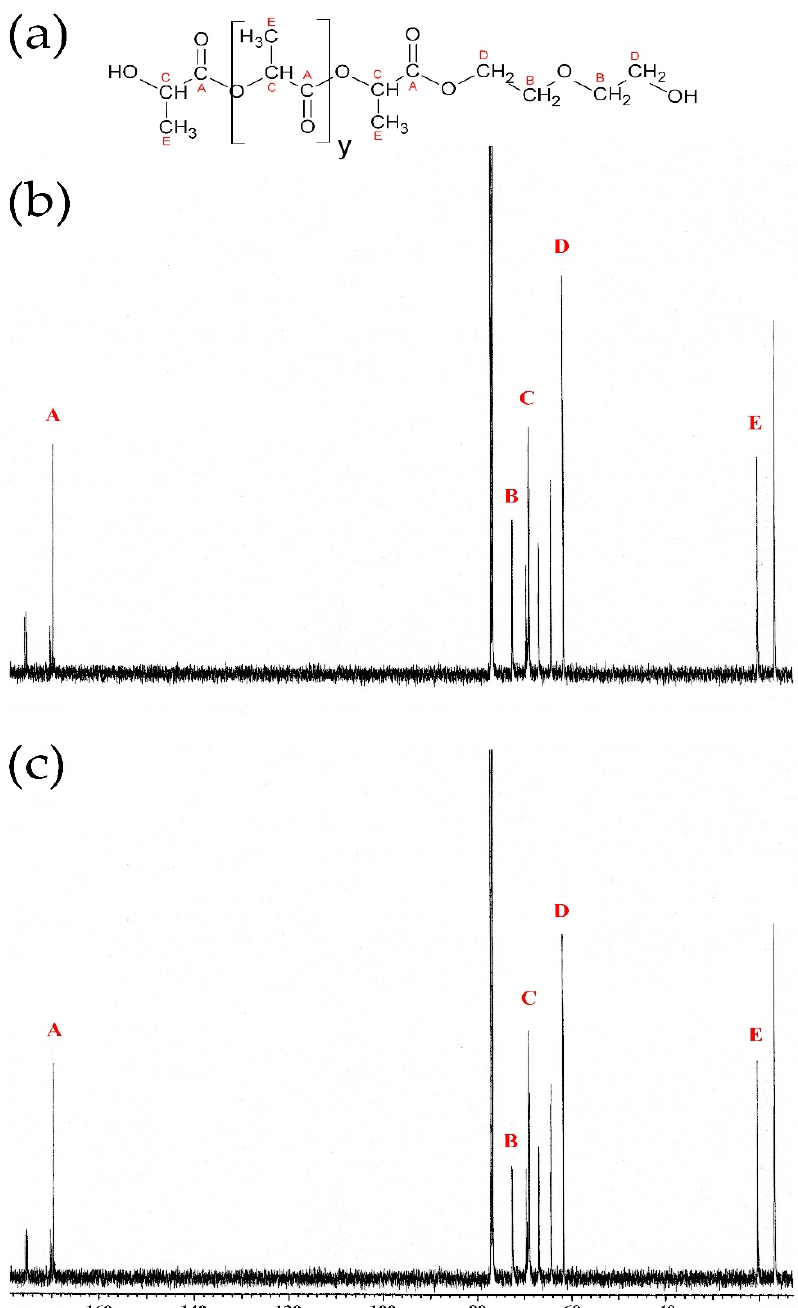
Figure 5. 13 C NMR spectra of new eco-polyols: ( a ) schematic structure of eco-polyols, ( b ) PLA0.4DEG spectrum, ( c ) PLA0.3DEG spectrum.